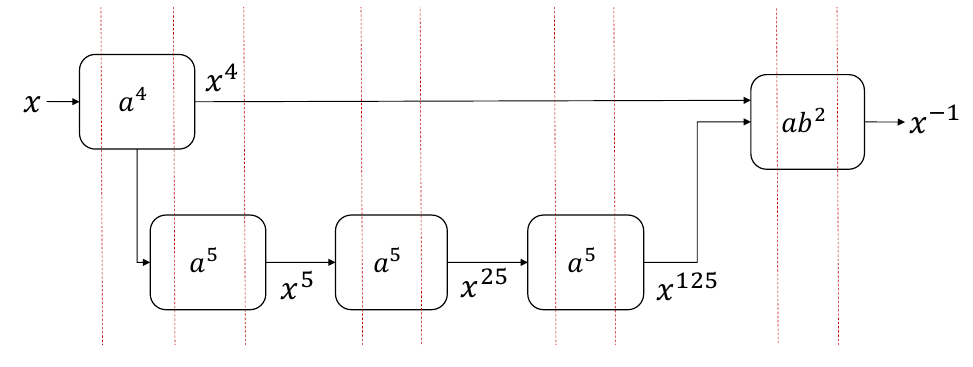
Figure 5: Inversion pipeline. (Register stages are depicted by red dotted lines.)